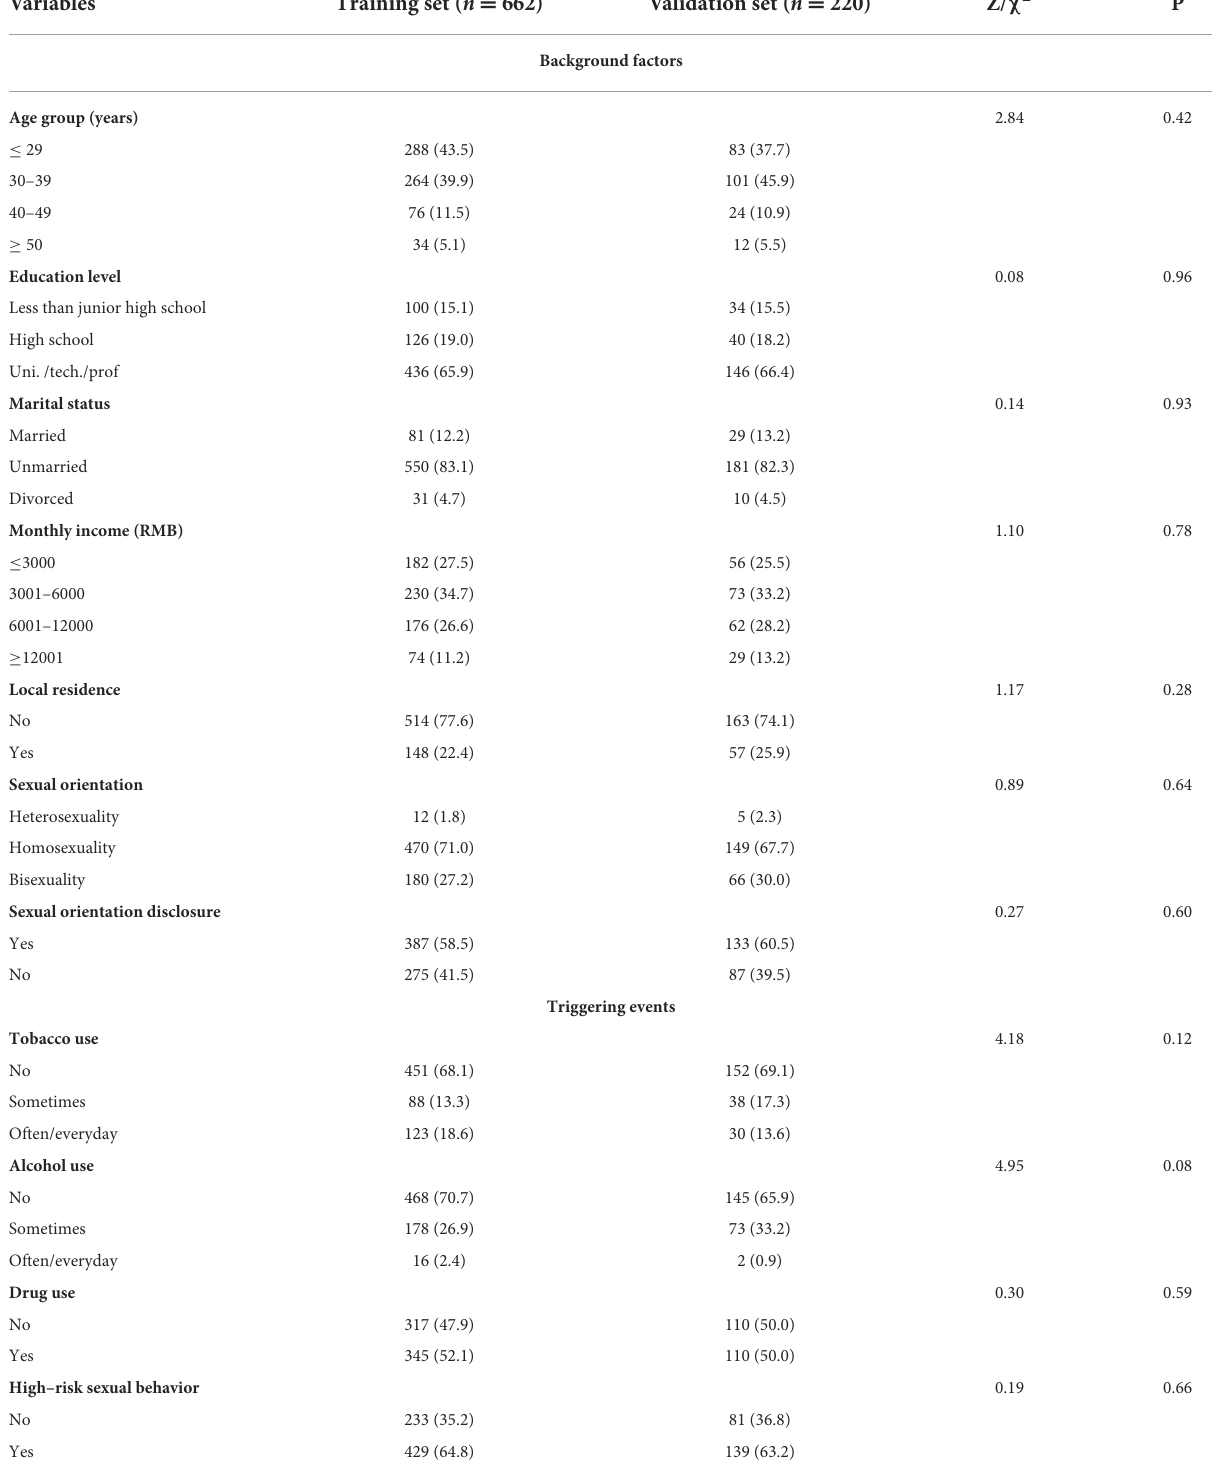
TABLE 6 Descriptive analysis and test of difference between training set and validation